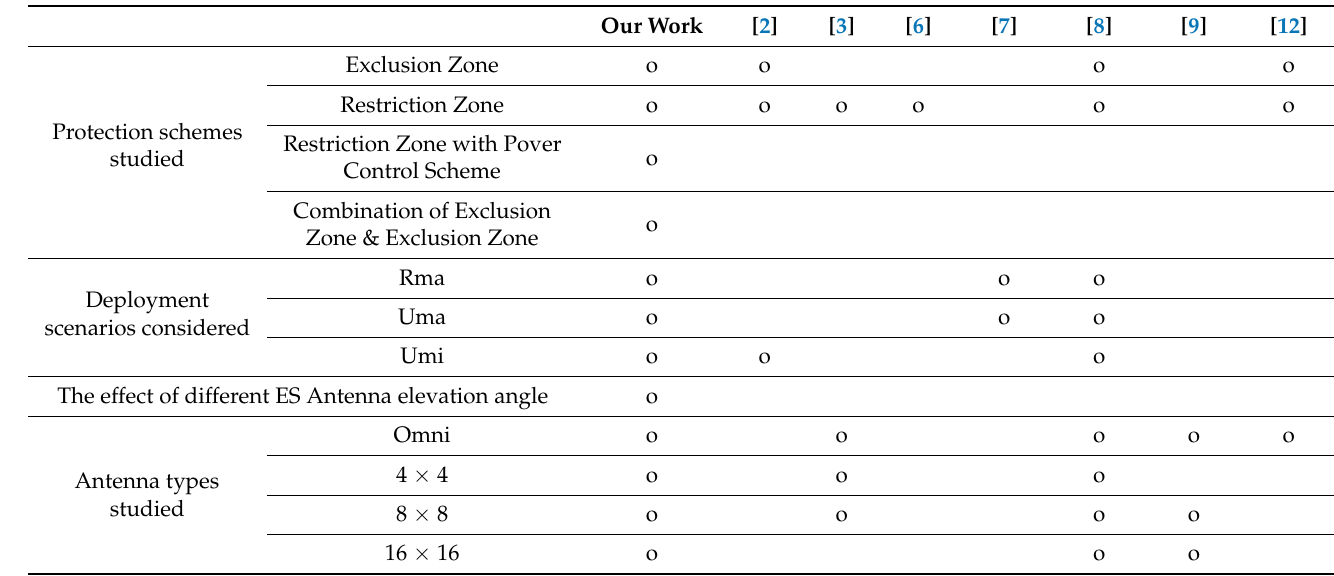
Table 1. The main differences between our work and previous